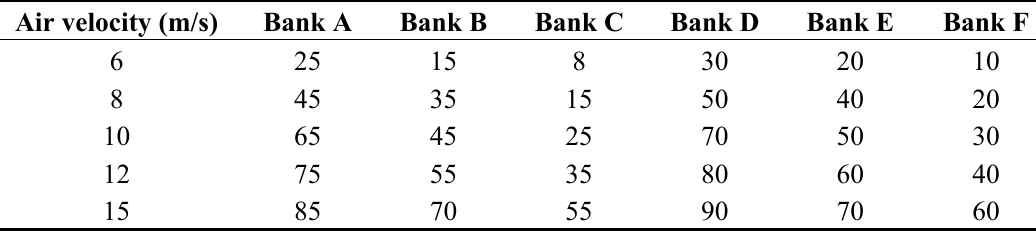
Table 4. Experimental pressure drop data Δ p